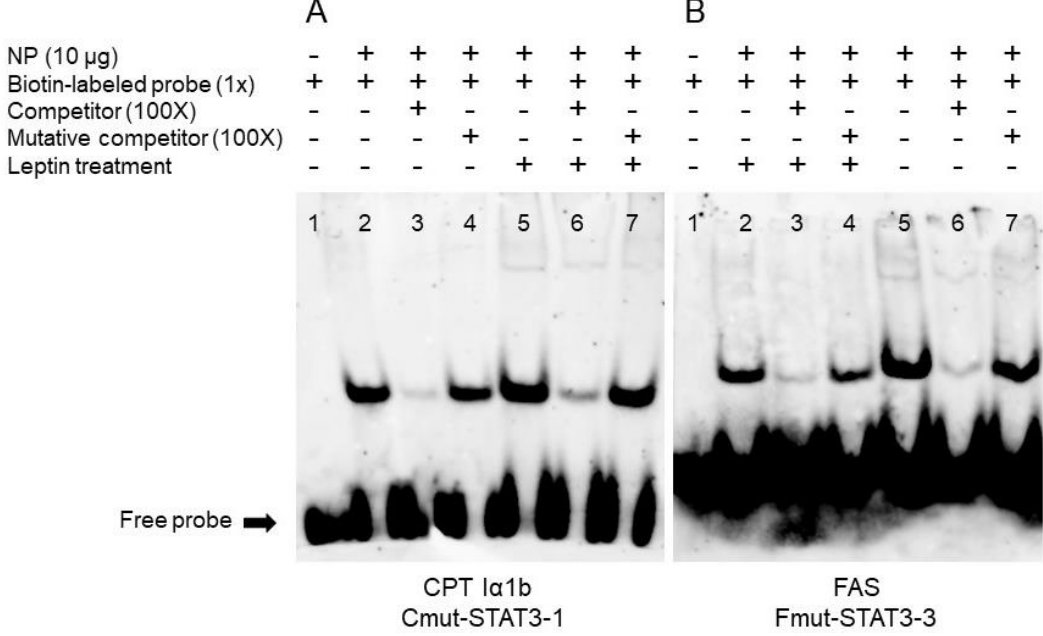
Figure 4. EMSA of predicted STAT3 binding sequence. ( A ) STAT3 binding sequences sited between − 979 bp and − 997 bp of CPT I α 1b promoter; ( B ) STAT3 binding sequences sited between − 794 bp and − 812 bp of FAS promoter. NP, nuclear protein.